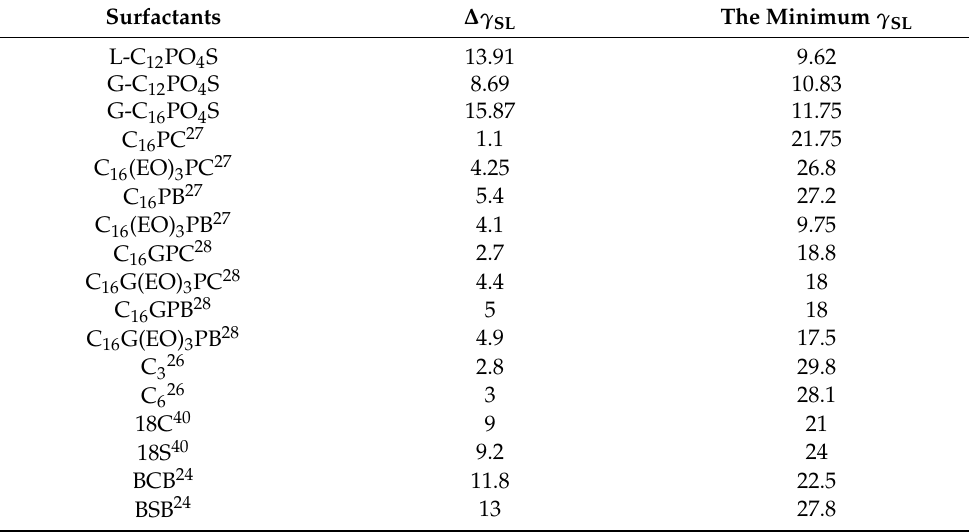
Table 4. The maximum hydrophobic modification and the maximum hydrophilic modification of the special surfactants on PMMA surface in the